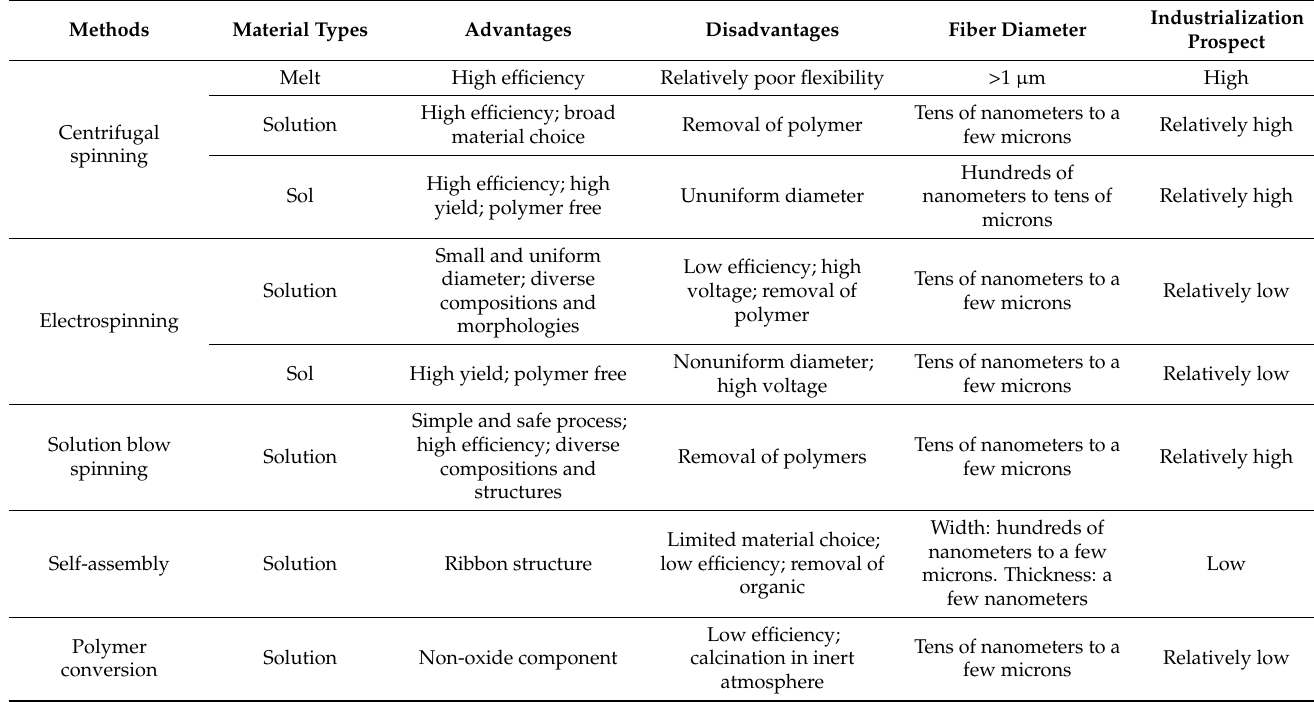
Table 1. Comparison of the main method for nanofiber preparation [1] (Adapted with permission from Ref. [1]. 2022 Donghua